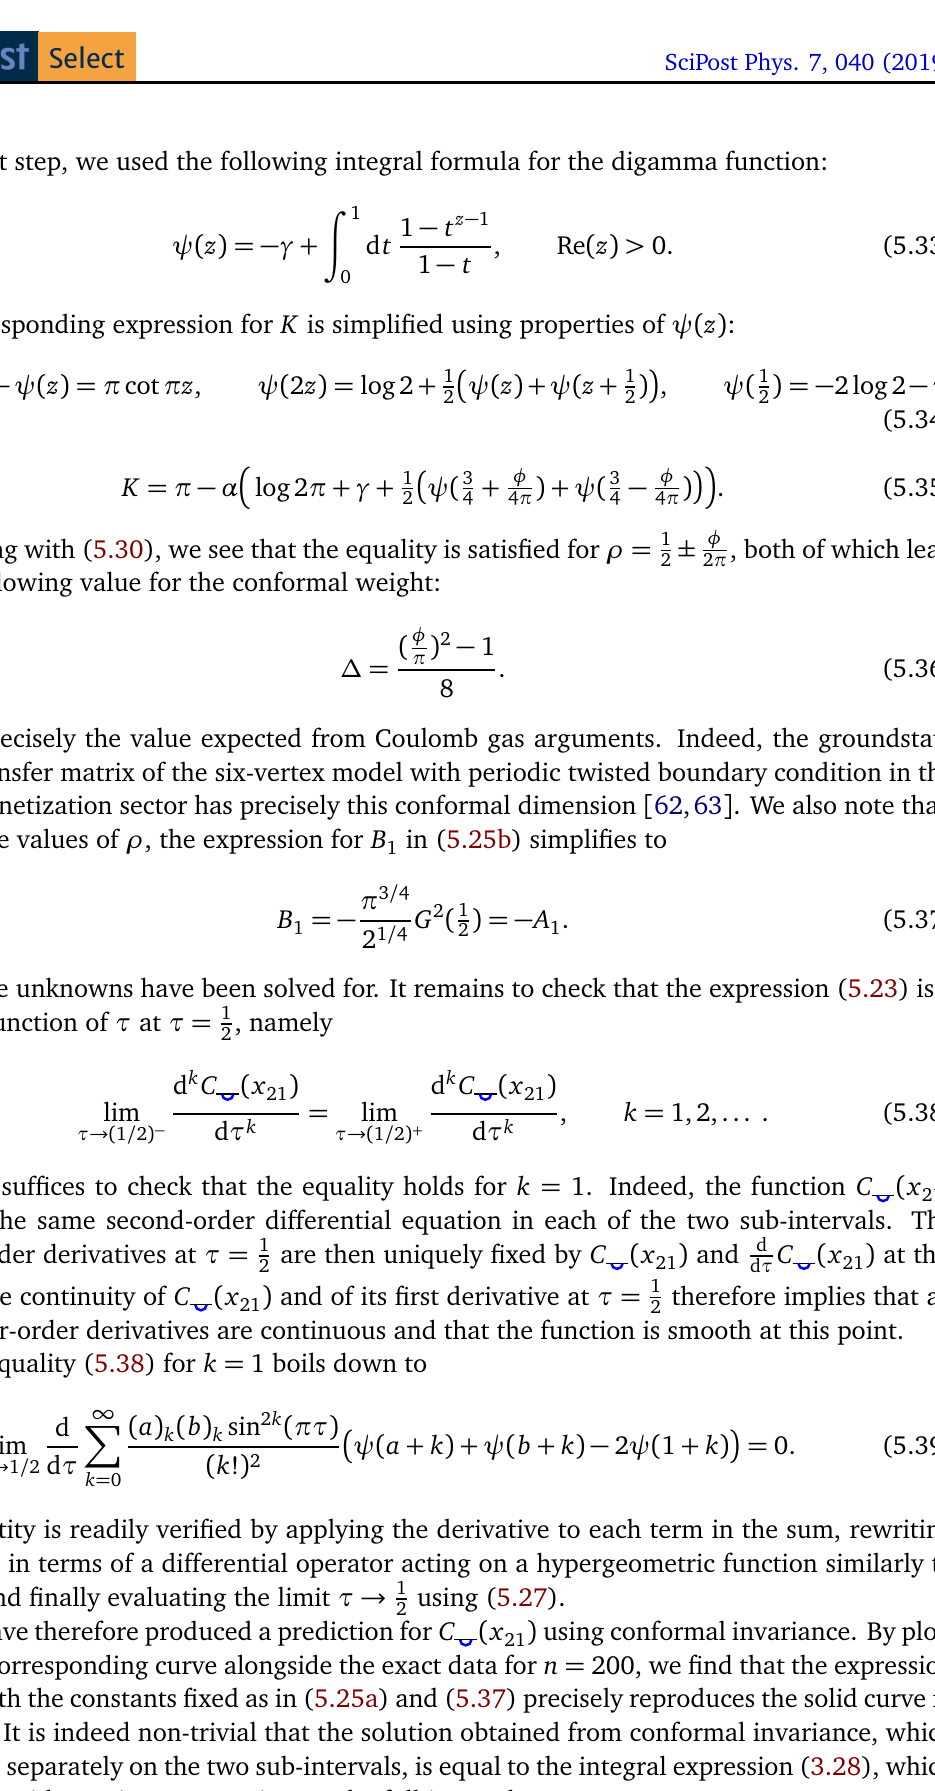
Figure 2. It is indeed non-trivial that the solution obtained from conformal invariance, which is defined separately on the two sub-intervals, is equal to the integral expression (3.28), which is defined with a unique expression on the full